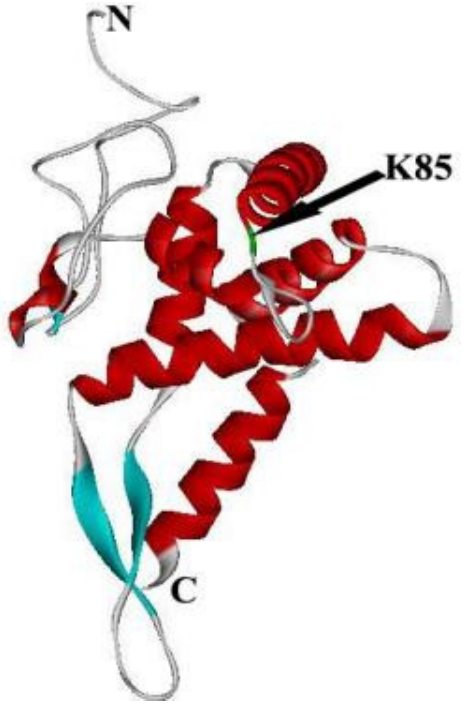
Figure 3. Crystal structure of Homo RPS5 is separated from the structure of Homo 40S using software 167 of chimera. The green domain is K85.